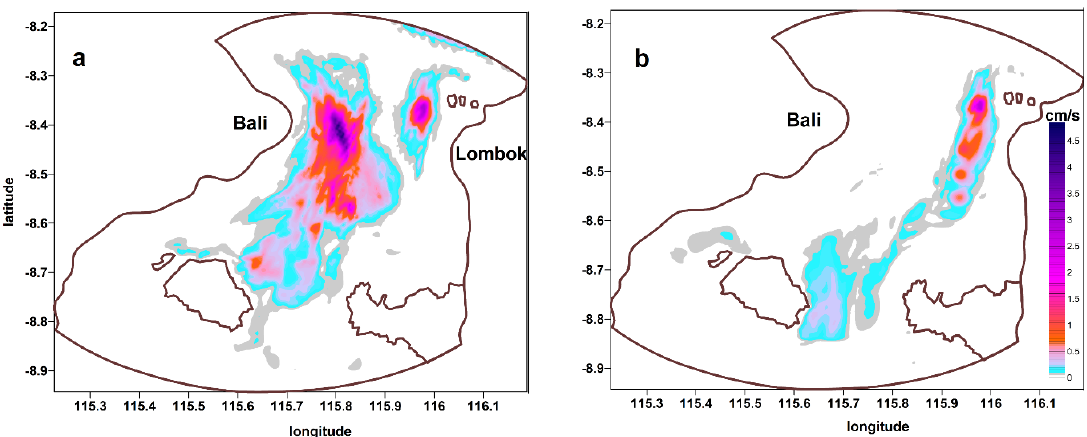
Figure 10. Nonlinearity in the vertical velocity near the bottom. ( a ) Hs approach; ( b ) Nh approach.